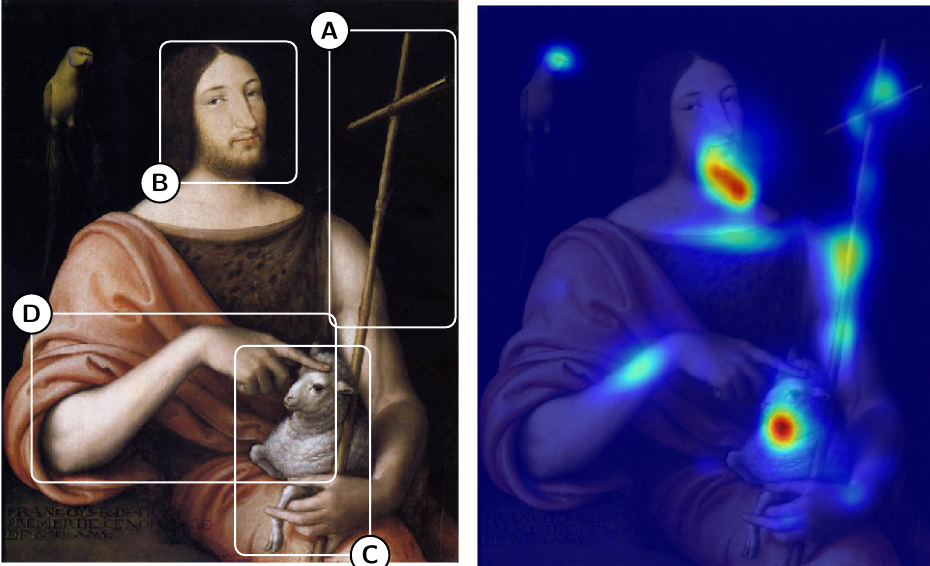
Figure 1. On the left: Saint John the Baptist image and iconographic symbols identified manually (e.g., cross ( A ), face ( B ), and lamb ( C ), and hand pointing at lamb ( D )). On the right: the CAM heat map associated with classification results of a CNN-based